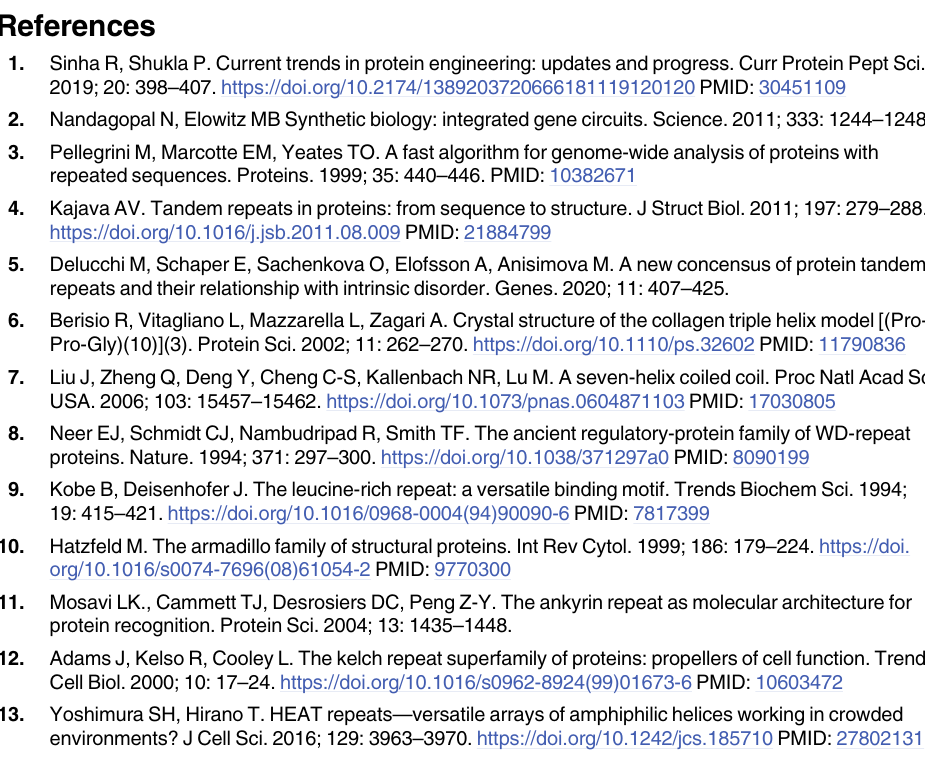
S1 File. Supplementary Information for TReSR: A PCR-compatible DNA sequence design method for engineering proteins containing tandem